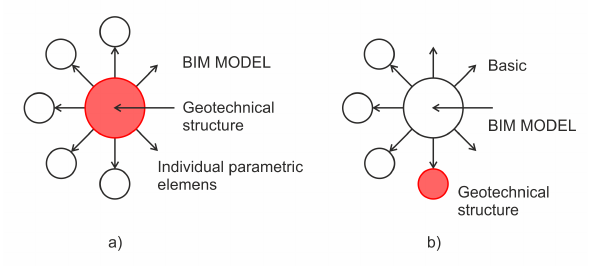
Figure 2. The position of geotechnical BIM model for various geotechnical structures. Ad a) Geotechnical structure creates a basic BIM model. Ad b) GS creates an individual parametric elementaround basic BIM